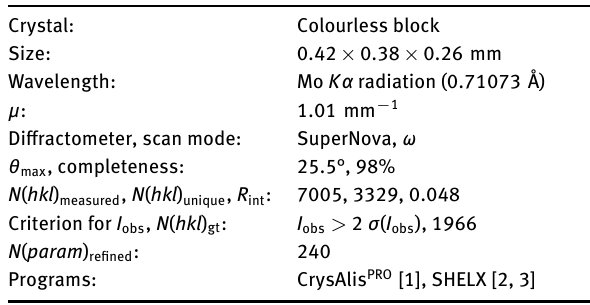
Table 1: Data collection and handling.